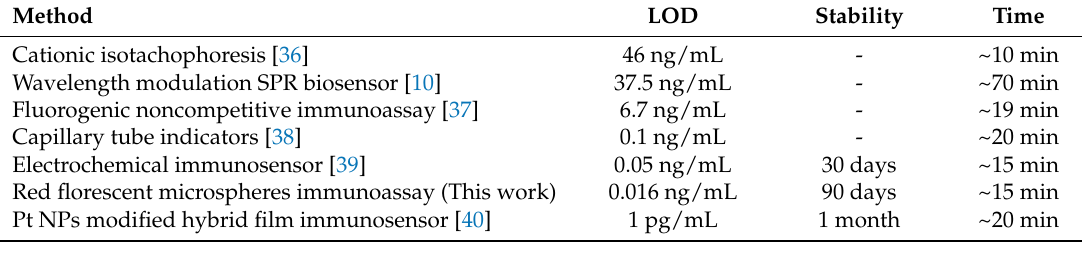
Table 1. The comparison of performance for cTnI from reported literatures and current work.